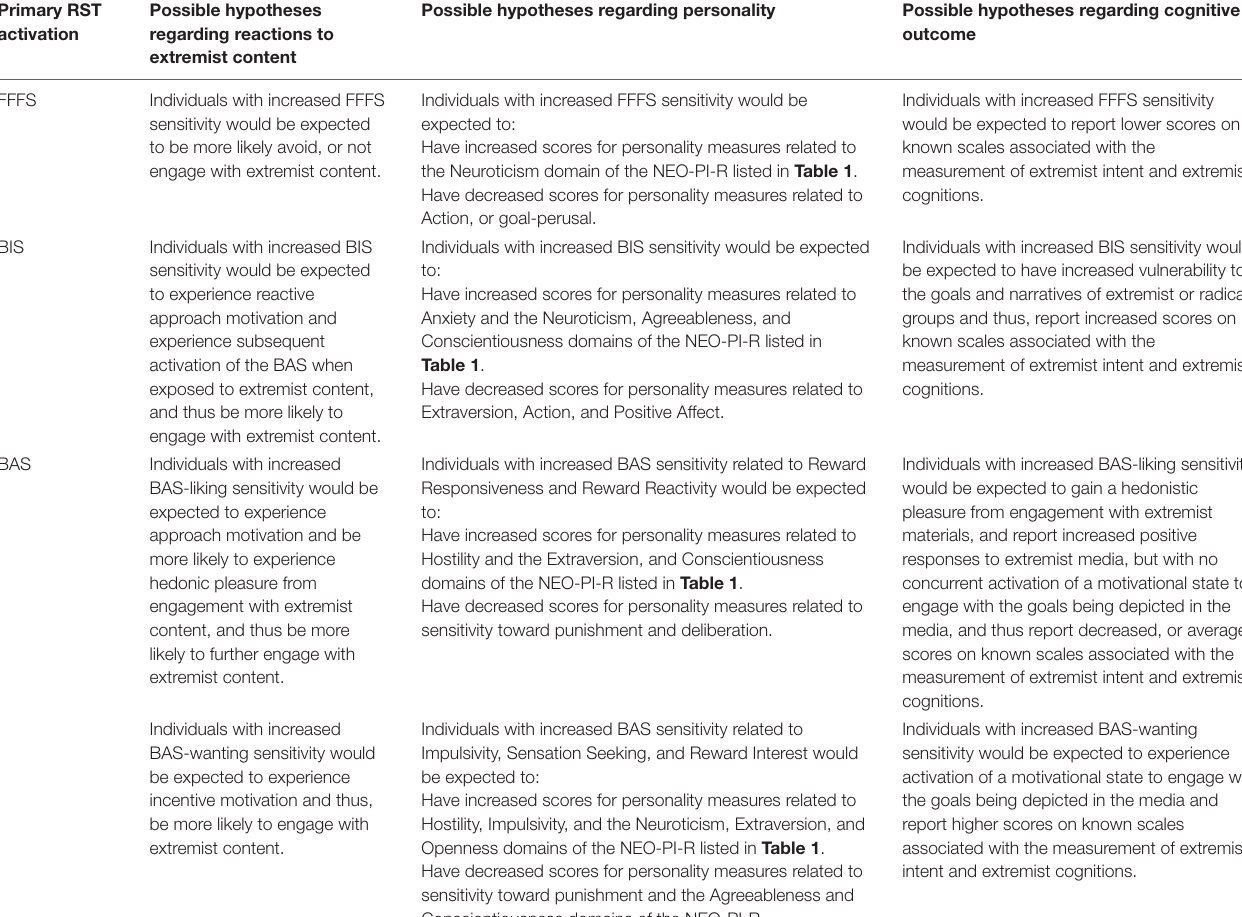
TABLE 2 | Possible hypotheses involving Reinforcement Sensitivity Theory (RST) personality traits and reactions following exposure to extremist content. Primary RST